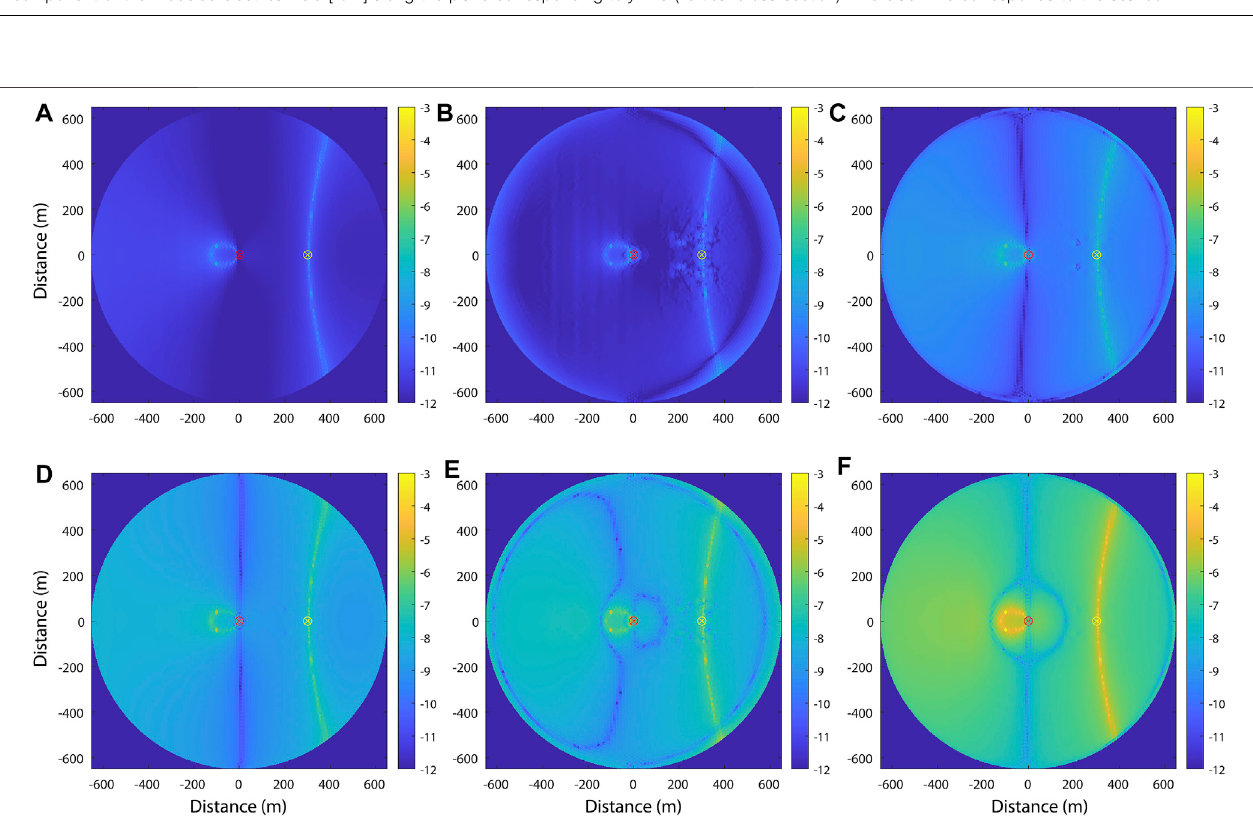
FIGURE 7 | Absolute value of the derivative of the electrical fi eld ( x -component) with respect to conductivity change for different corrosion levels. The plots correspond to the result at the sea fl oor. Horizontal and vertical axis correspond to x - and y -axis, respectively. The well is at the center of the plots, while the source is located at y = 0 m and x = 300 m, marked with a yellow dot. The plots are derived using Eq. 2 with conductivity levels of 4 × 10 5 S/m (A) , 4 × 10 4 S/m (B) , 4 × 10 3 S/m (C) , 4 × 10 2 S/m (D) , 4 S/m (E) , and 40 S/m (F) , respectively. All the plots are using logarithmic scale.